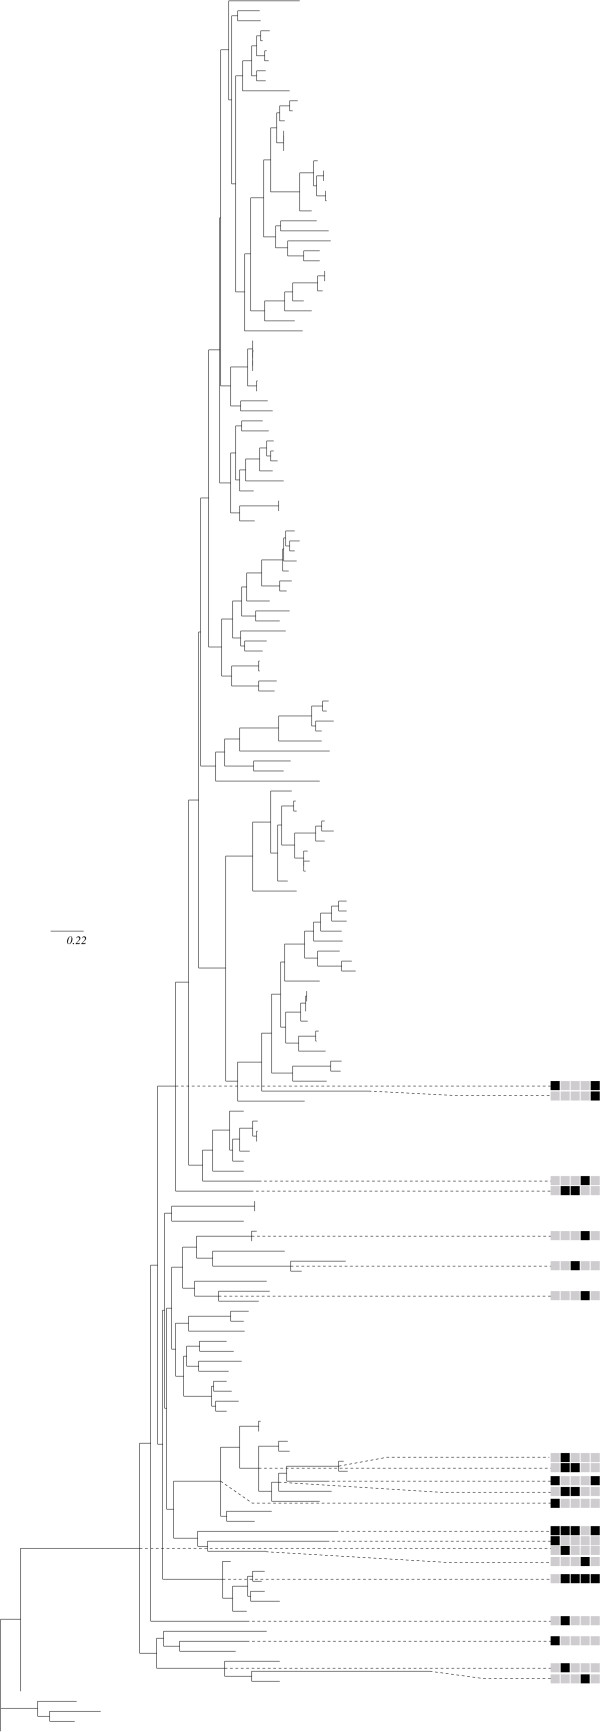
Unweighted substitution mapping for pair (CYS78, ASN95, SER110, GLY150, GLN233) of the MAP data set (see tables 5), revealing a probable rate shift. Only mappings for nodes with at least one site with at least ± 0.9 substitution on average have been represented for clarity. Same legends as in figure 3.